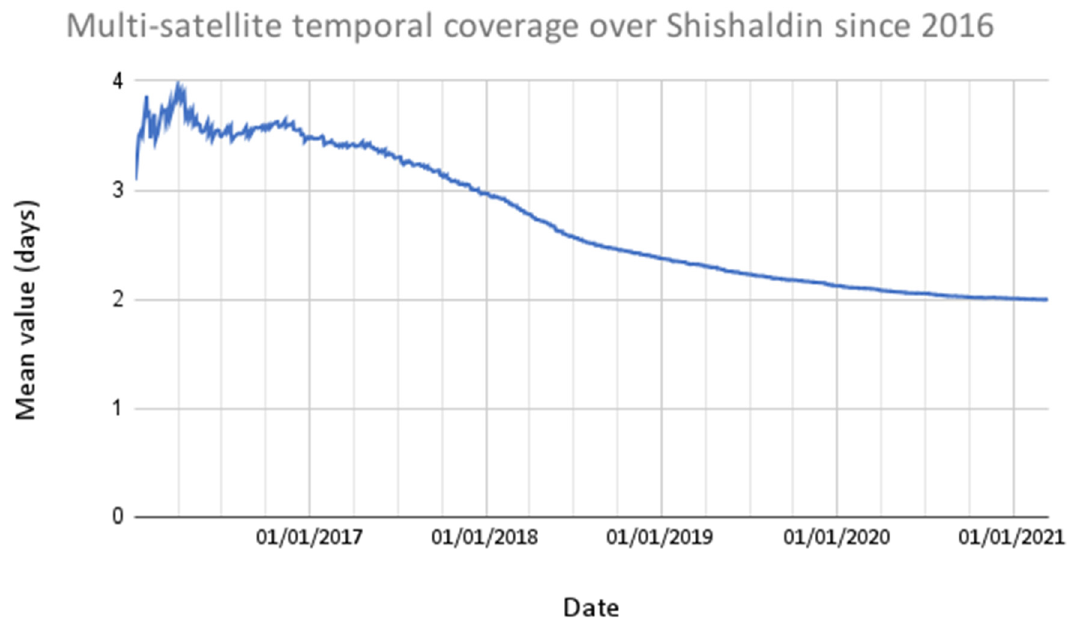
Figure 12. Evolution (2016–2021) of the temporal coverage achievable using a multi-satellite monitoring system integrating L8-OLI, S2-MSI and Terra-ASTER observations. The plot shows for the Shishaldin volcano location the average temporal gap among observations. Note as the launch of Sentinel-2B at the end of 2017 dramatically reduced the temporal gap from 4 on average (maximum 9) to 2 (maximum 3)